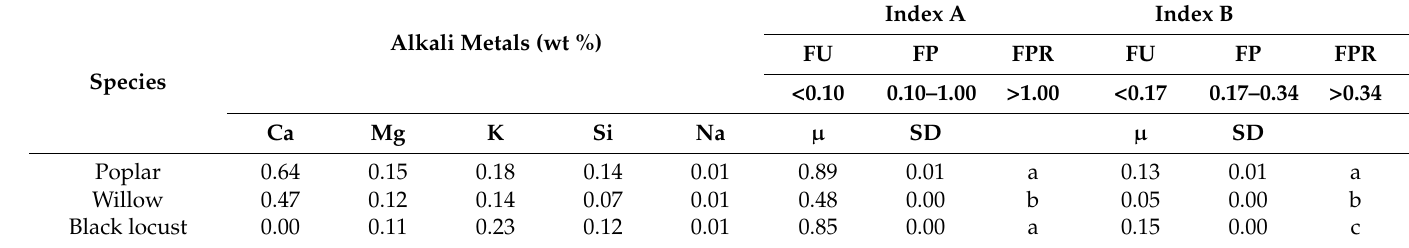
Table 5. Alkali metal and silicon content in poplar, willow and black locust (means values, dry basis) and fouling indexes determined and fouling indexes range.